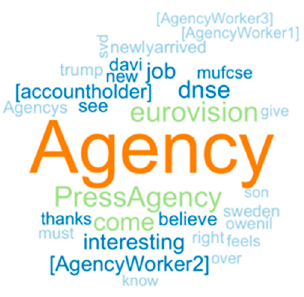
Figure 1. Word cloud of all tweets.